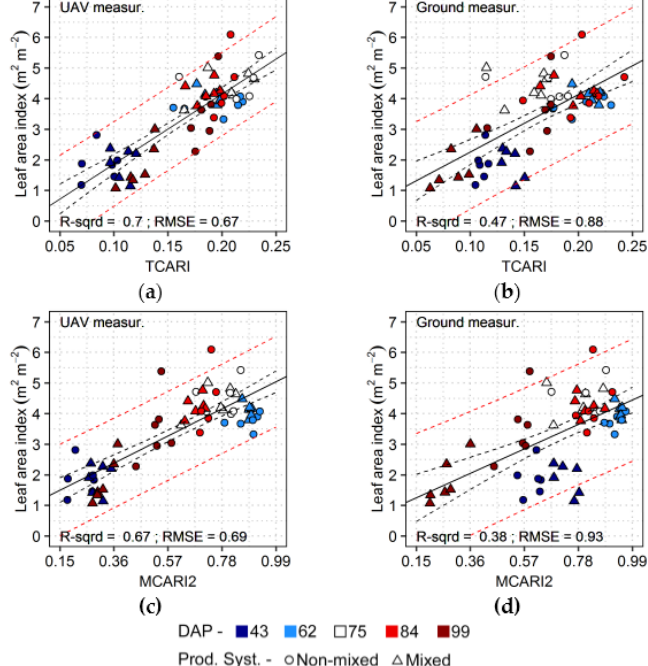
Figure 7. Best vegetation index for prediction of leaf area index from UAV data ( a ), results for an index designed to predict leaf area index ( c ), and corresponding results for ground-based measurements ( b , d ). Red and black dashed lines indicate prediction and confidence intervals with 95% confidence level, respectively.